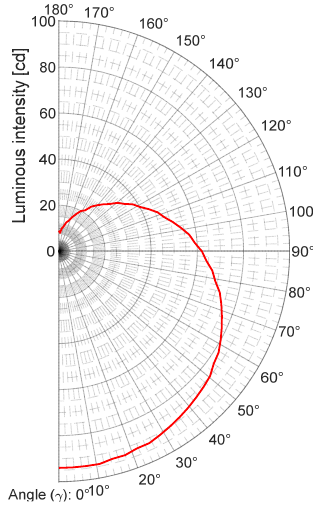
Figure 17. Polar diagram of the angular distribution of the luminous intensity.